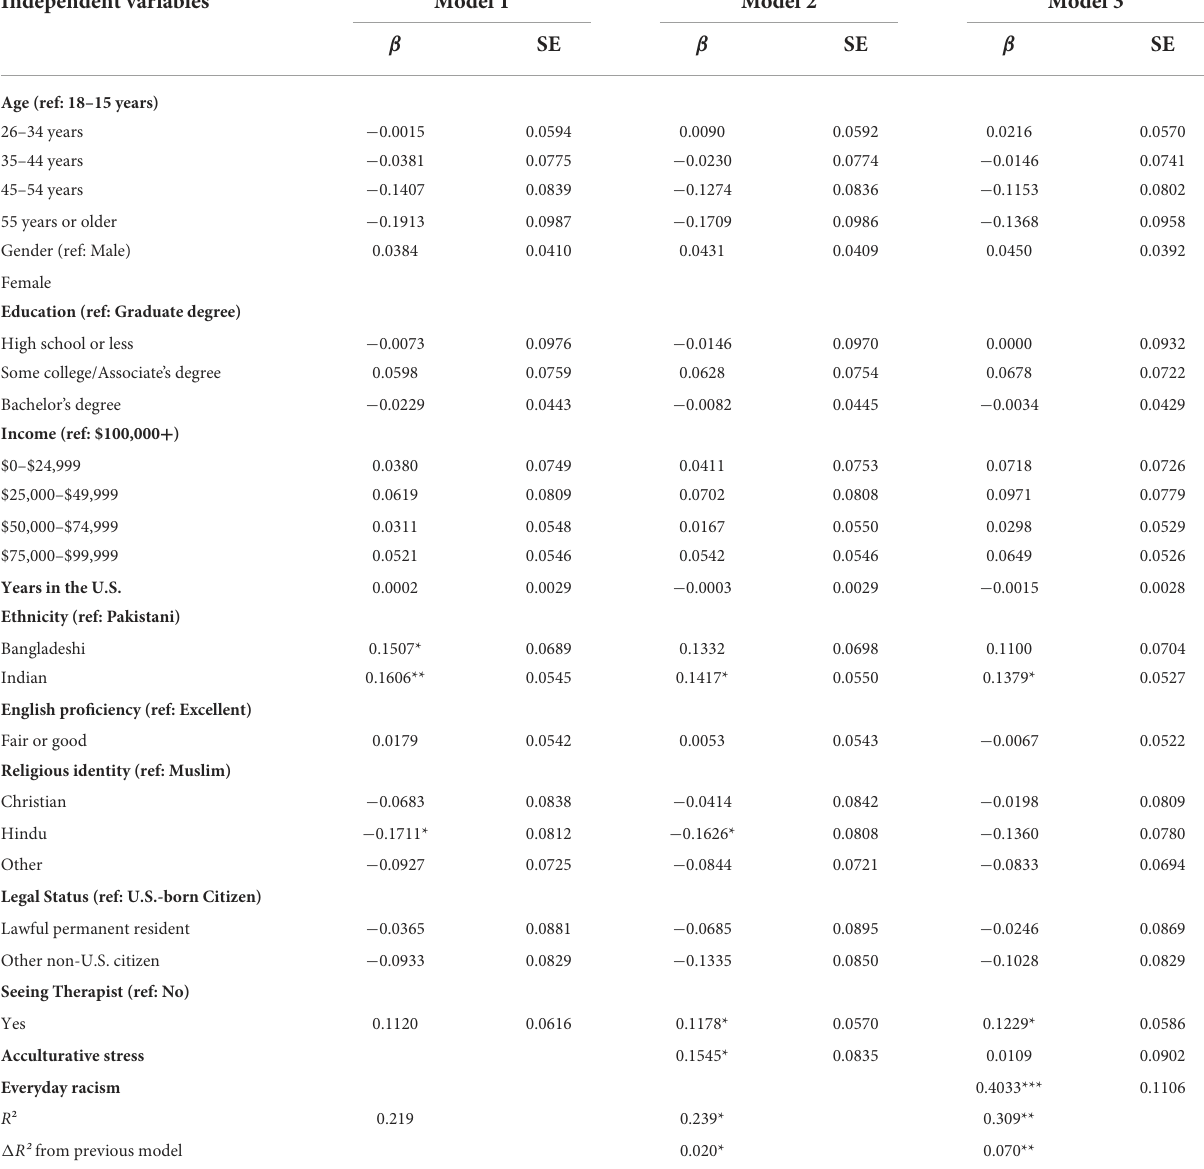
TABLE 3 Hierarchical multiple regression models predicting depressive symptoms ( n = 200). Independent